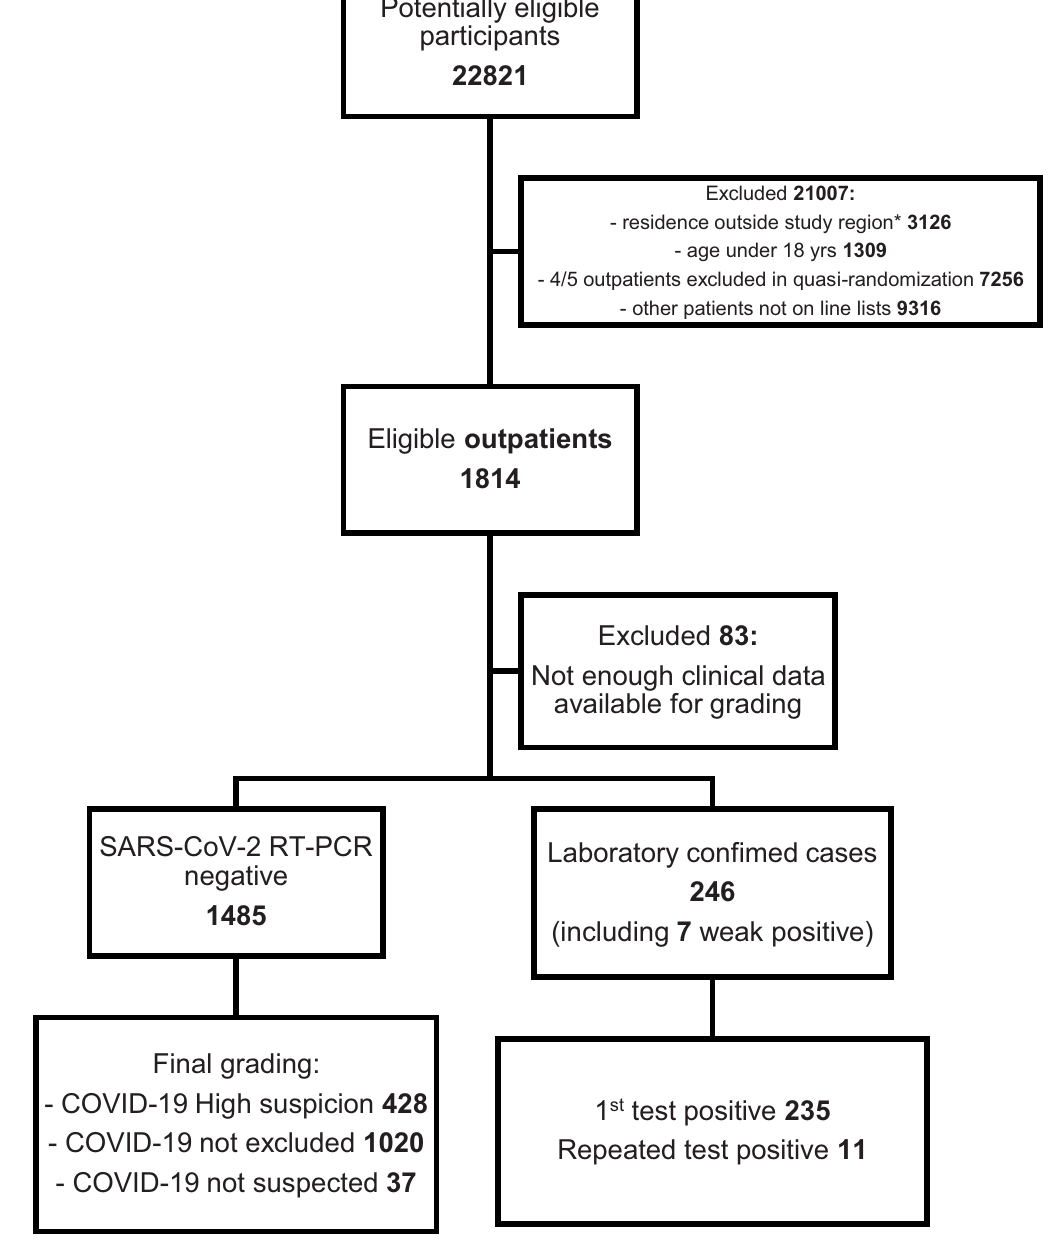
Fig 1. Selection of the outpatient cohort presented as a